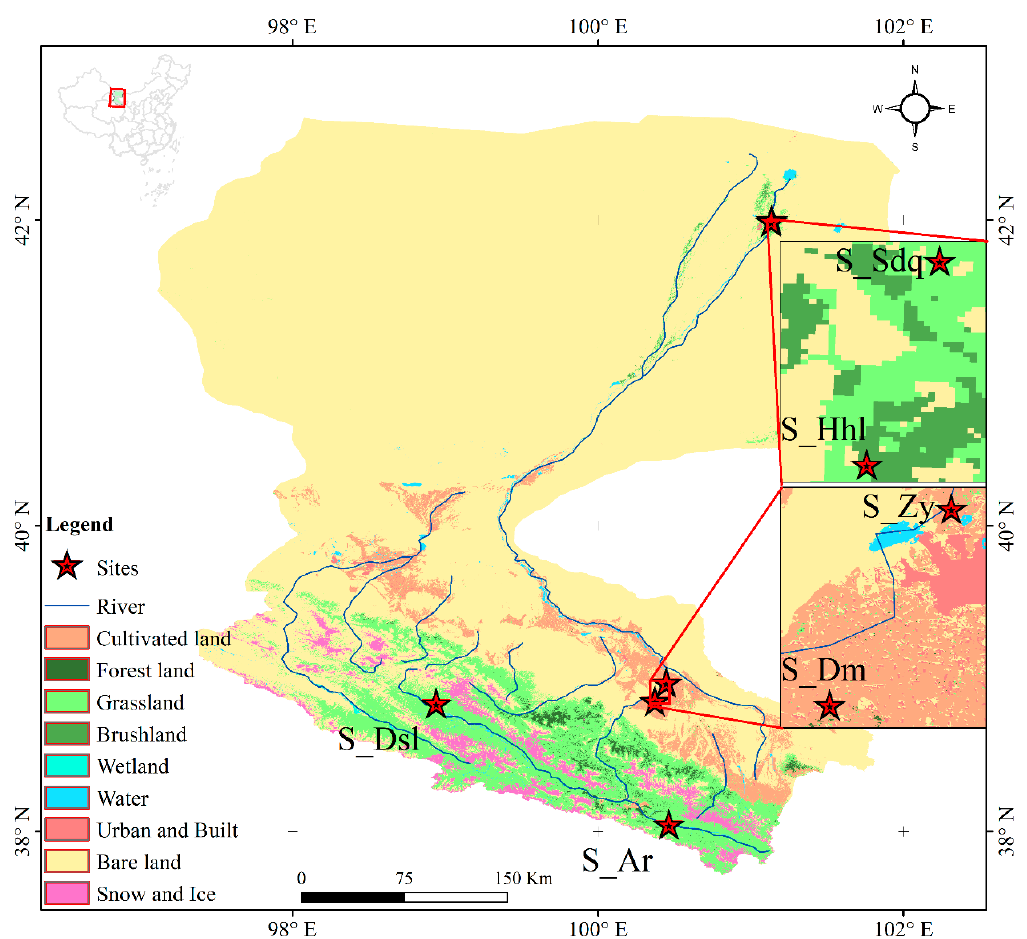
Figure 1. Distribution of the six flux sites in northwestern China. The land cover classification data are from land use and land cover data of the Heihe River Basin in 2000 (http://www.heihedata.org/data/). The S_Dm site and the S_Zy site are located in the Daman and Yingke irrigated areas near Zhangye city Gansu province, respectively. They are also in the midstream of the Heihe river (artificial oasis experimental area) having a continental arid climate [32]. The S_Zy site is situated on a wetland with a reed surface in the Zhangye National Wetland Park. The S_Ar and the S_Dsl sites are part of the upstream cold region experimental area. The former is in a valley with an east-west direction and a maximum width of 3 km [15]. The latter is covered with snow most of the time [34]. The S_Sdq and the S_Hhl sites are located on the natural oasis experimental area in the downstream. More information can be found in Table 1 and Figure 1.